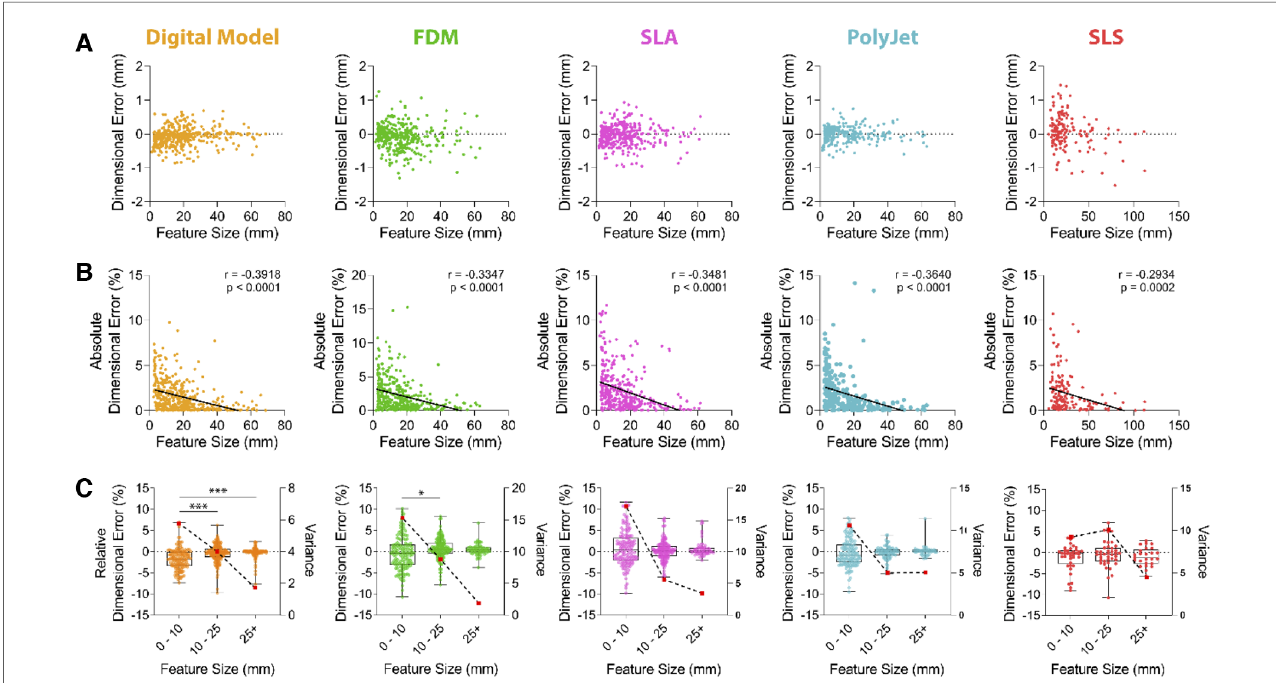
FIGURE 4 Dimensional accuracy of vascular M3DP models as a function of feature size. Dimensional error of digital and M3DP models as compared to original volumetric imaging datasets shown as ( A ) aimensional error in millimeters, ( B ) absolute dimensional error in percentage deviation (solid line demonstrates linear regression analysis; r =Pearson ’ s correlation coef fi cient) and ( C ) over discreet feature size ranges, 0-10 mm, 10-25 mm and over 25 mm (relative dimensional error is shown in boxplots and plotted on left axis; Variance is indicated using broken line and red dots and plotted on right